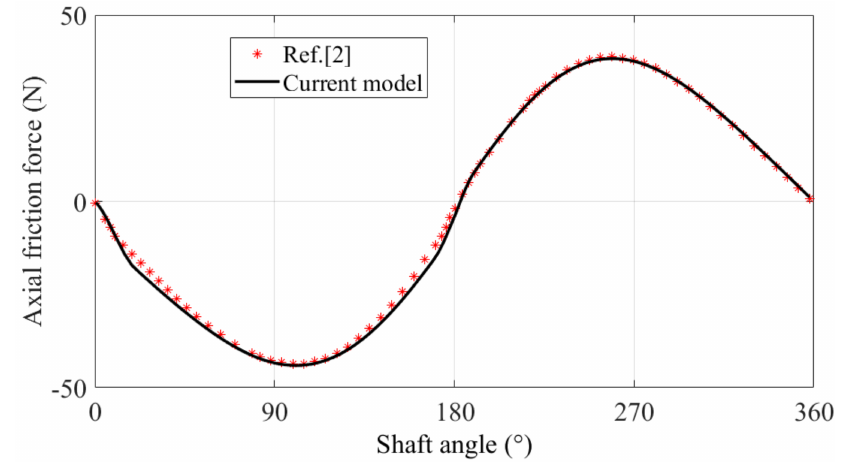
Figure 6. Transient axial friction force in comparison with the result from